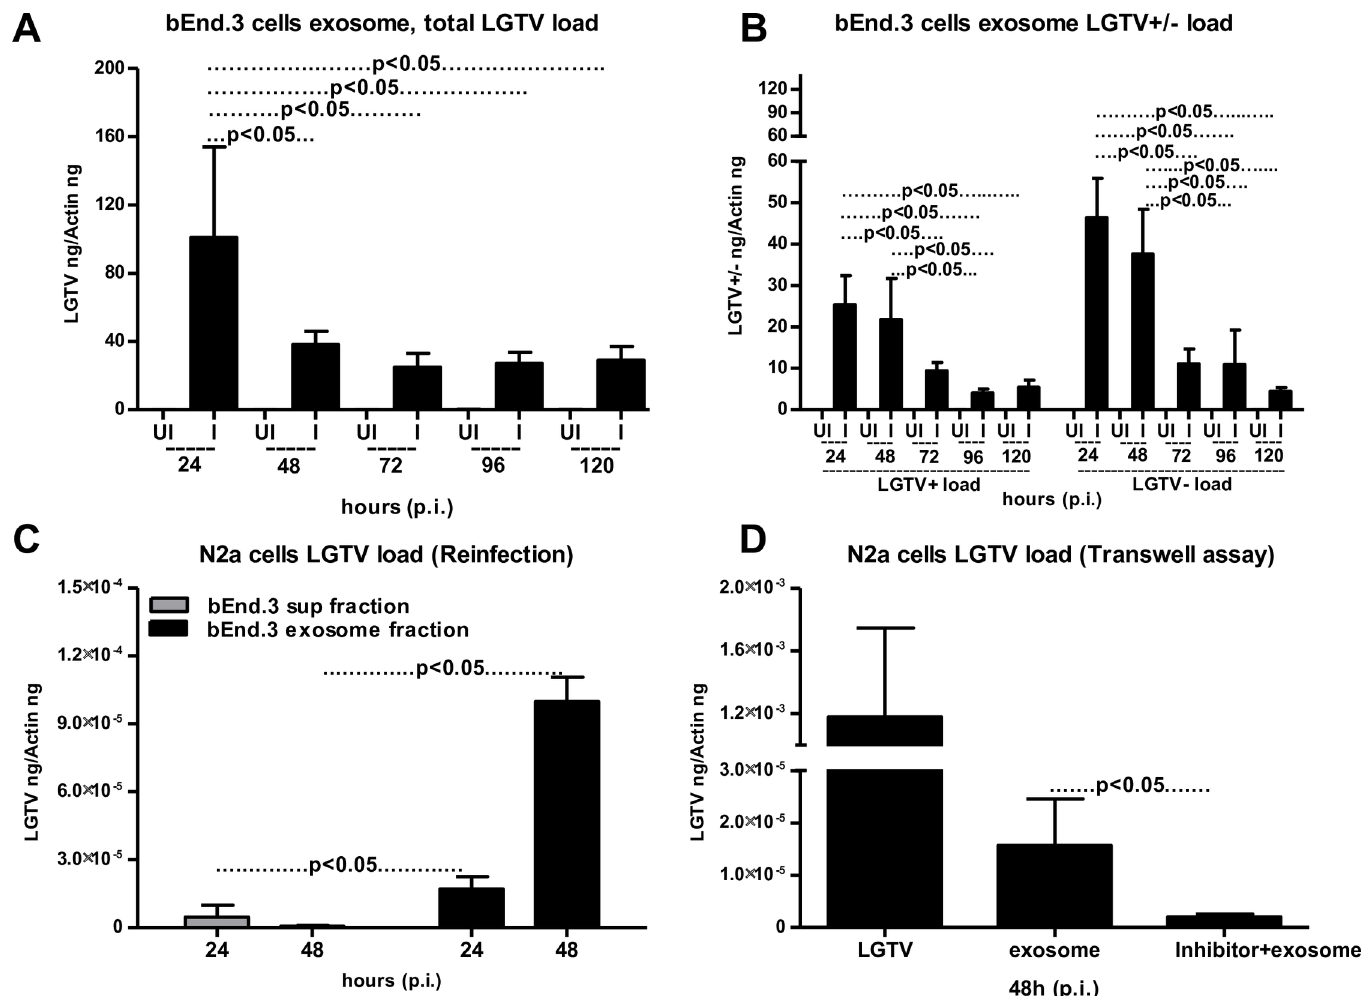
Fig 2. Endothelial cell-derived exosomes mediate transmission of LGTV RNA from bEnd.3 cells to N2a neuronal cells. The bEnd.3 cells (1 x 10 5 ) were infected with 6 MOI of LGTV. QRT-PCR analysisshowingtotal LGTV loads (A) or levels of LGTV positive-sense strand or negative-sense strand (B) in exosomes isolatedfrom bEnd.3 cells at different time points (24, 48, 72, 96 and 120 h p.i.). (C) Viral loads were determined after 24 h p.i. by the presenceof LGTV in N2a cells (1 x 10 5 ) treated with LGTV containing exosomes (20 μ l) or supernatant(400 μ l) fractions preparedfrom 24 or 48 h p.i. of bEnd.3 cells. (D) Viral loads at 48 h p.i. of N2a cells (plated in lower chamber) as determinedby the presenceof LGTV in a transwellassay performed with 1x 10 5 of bEnd.3 cells treated with 20 μ l brain endothelialcell-derived exosomes (in upper chamber)for 4 h in the presence or absenceof exosome inhibitor(5 μ M) (in upper chamber) or infected with LGTV laboratory virus stocks is shown. LGTV transcript levels were normalized to mouse beta-actin. P value determined by Student’s two-tail t test is shown. Representative data is shown from three independentexperiments. fractions isolated from the bEnd.3 cells ( Fig 2C ). Transwell assays performed with exosomes isolated from LGTV-infected-brain endothelial cells showed transmission of viral RNA and proteins from bEnd.3 cells (plated in upper inserts) to uninfected/naïve N2a cells seeded in the lower well ( Fig 2D ). Presence of exosome inhibitor significantly reduced transmission of LGTV infectious RNA from bEnd.3 cell-derived exosomes to N2a cells ( Fig 2D ). Infection of bEnd.3 cells with laboratory virus stocks with known titers (6 MOI) showed transmission of LGTV to N2a cells (by crossing the membrane barriers in transwell plates) and served as con- trol in this assay ( Fig 2D ). These results suggest that exosomes derived from brain-endothelial cells are perhaps the mediators for BBB permeability (crossing of infectious exosomes from